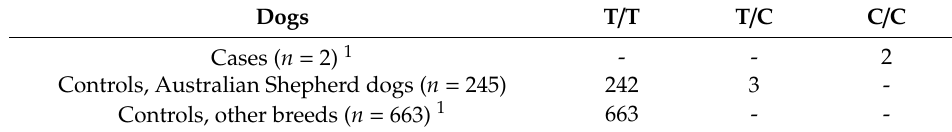
Table 3. Genotype-phenotype association of the LAMB3 :c.1174T > C variant with JEB.